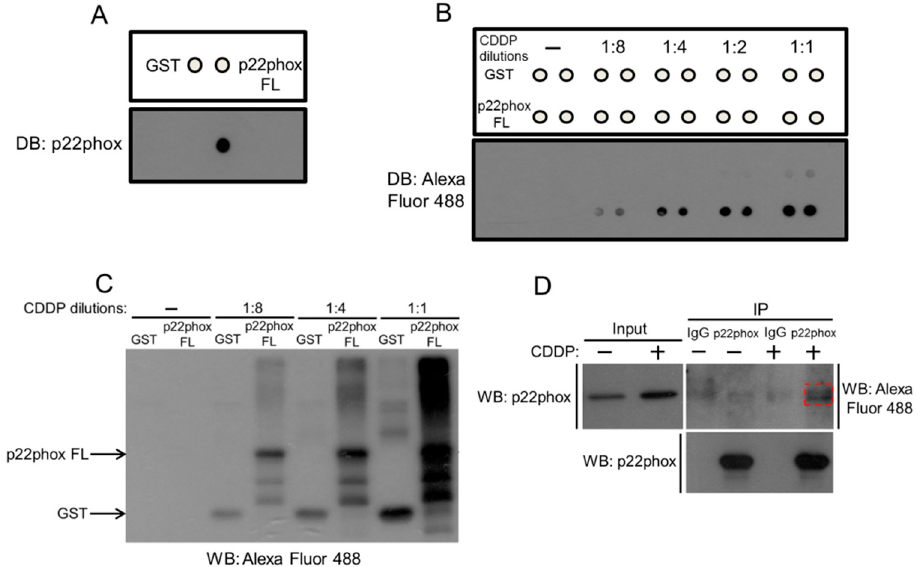
Figure 1. p22phox protein interacts with CDDP in vitro. ( A ) The identity of GST-p22phox full-length recombinant protein (or p22phox FL) was verified by dot blot analysis using anti-p22phox. The recombinant GST and p22phox FL proteins were immobilized to the sepharose GSH beads, and then incubated in PBST buffer with or without increasing dilutions (1:2–1:8) of Alexa Fluor 488-labeled CDDP at 37 °C for 1 h. The beads were analyzed by dot blotting ( B ) and immunoblotting ( C ). ( D ) p22phox-expressing SAS cells were treated with Alexa Fluor 488-labeled CDDP overnight and the cell lysates were immunoprecipitated with anti-p22phox or IgG control, followed by Western blotting with anti-Alexa Fluor 488 (dotted box) or anti-p22phox.